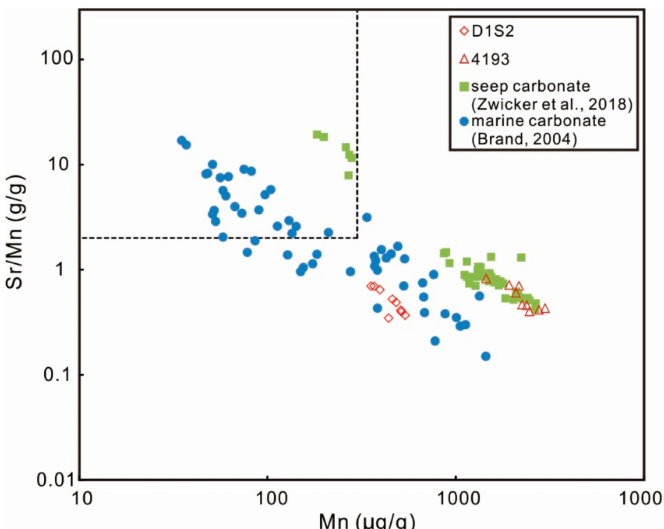
Figure 6. Plot of Mn / Sr ratio vs. Mn content of the primary low-magnesium calcite (LMC; open symbols) in this study and other carbonates used for comparison (filled symbols). It is suggested that carbonates with ≥ 2.0 Sr / Mn and < 300 µ g / g Mn (dashed line) retain Sr isotopes of original seawater [55]. The primary LMC reveal low Mn / Sr ratios and relative high Mn contents, which are not distinguishable from the diagenetically altered